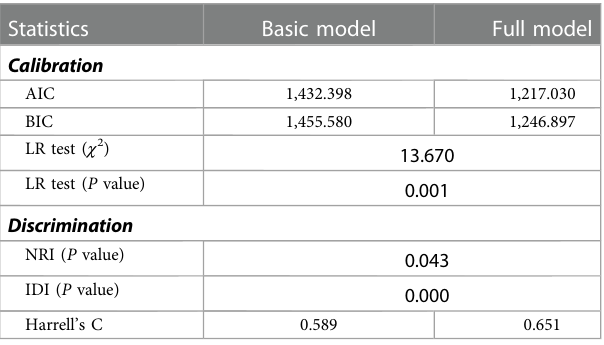
TABLE 3 Predictive accuracy of risk model with and without MAP-supine or USG for the prediction of VVS recurrence.